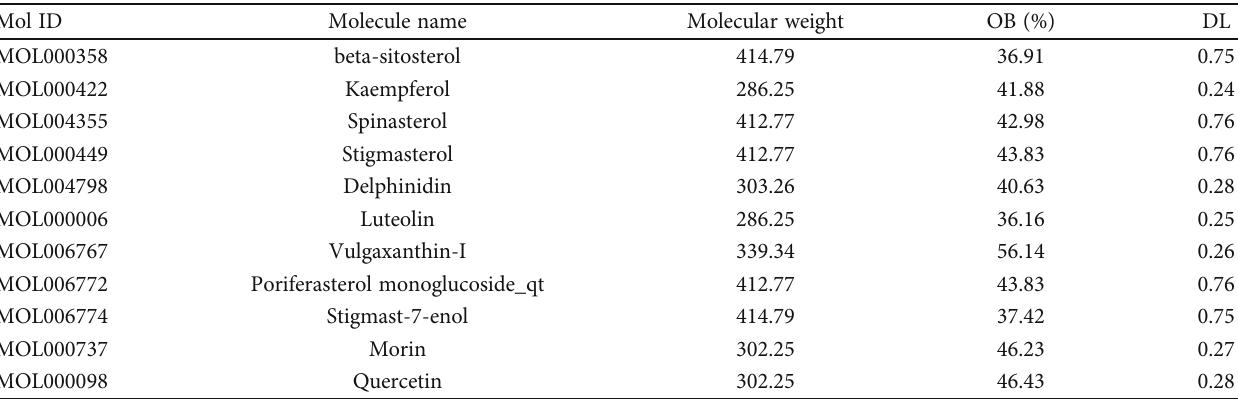
Table 1: Active ingredients of Prunella vulgaris L.